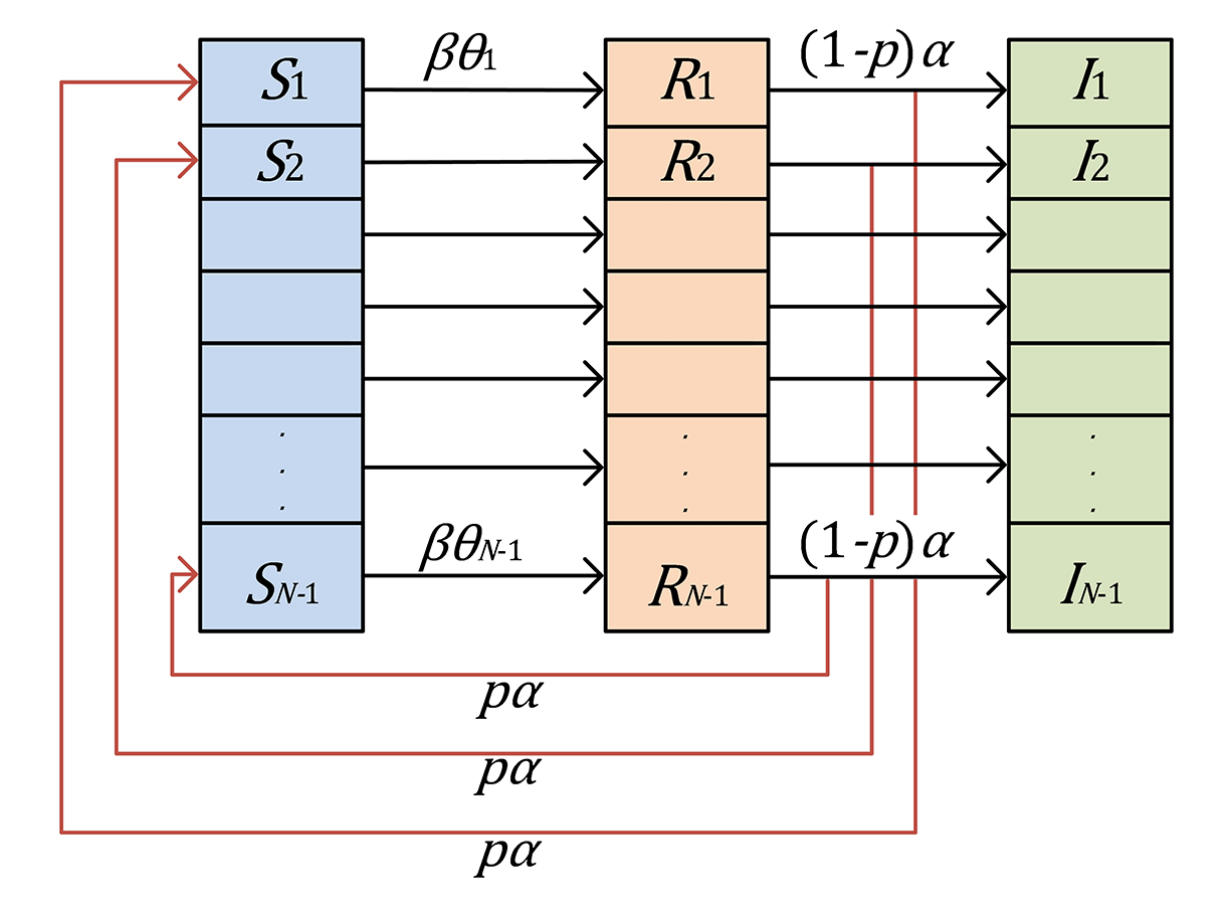
Figure 1. Inspired by infectious disease models, a network model diagram of information dissemination is proposed to simulate the transmission of information among the susceptible state (S), the reading state (R), and the immunized state